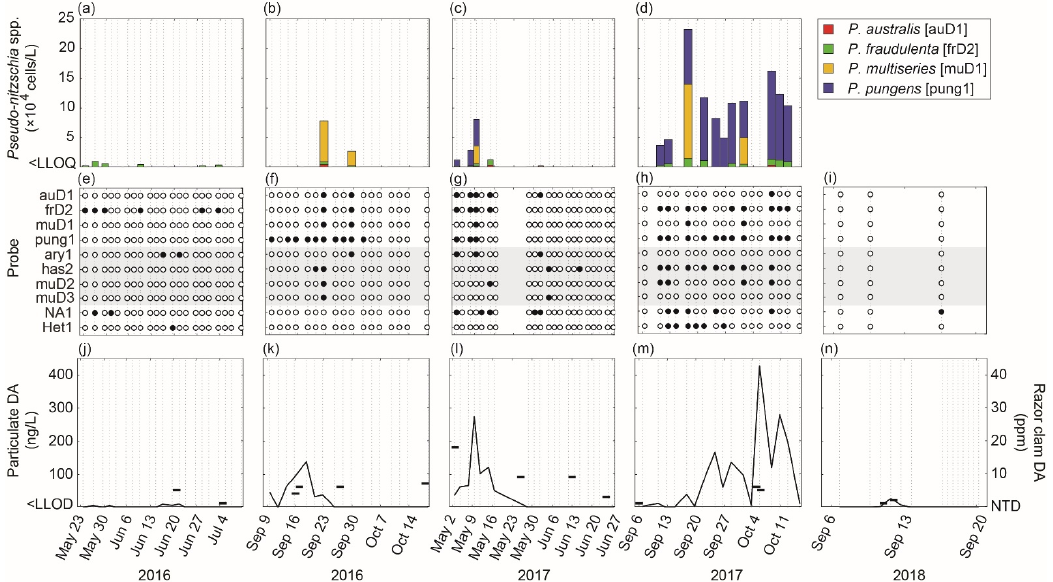
Figure 6. Monitoring results from the molecular analyses (SHA and cELISA) conducted onboard ESP during five deploy- ments over three years. ( a – d ) Stacked bar charts show the concentrations of Pseudo-nitzschia spp. targeted for quantification. Pseudo-nitzschia australis , P. fraudulenta , P. multiseries , and P. pungens concentrations are shown as black, dark gray, light gray, and white bars, respectively. Note that P. pungens was quantified in 2017 only. ( e – i ) Reactivity of all probes included on the HAB array (auD1 P. australis , frD2 P. fraudulenta , muD1 P. multiseries , pung1 P. pungens , ary1 P. arenysensis , has2 P. hasleana , muD2 P. multiseries / P. pseudodelicatissima , muD3 P. multiseries , NA1 A. catenella , and Het1 H. akashiwo ) with filled/open circles indicating that the target species was present/absent. Gray shading indicates Pseudo-nitzschia probes that were not targeted for quantification and that have not been validated using local strains of target organisms. ( j – n ) Concentrations of particulate domoic acid in seawater (line; left axis) and domoic acid in razor clams (dash; right axis) collected from ocean beaches in Jefferson County, WA.